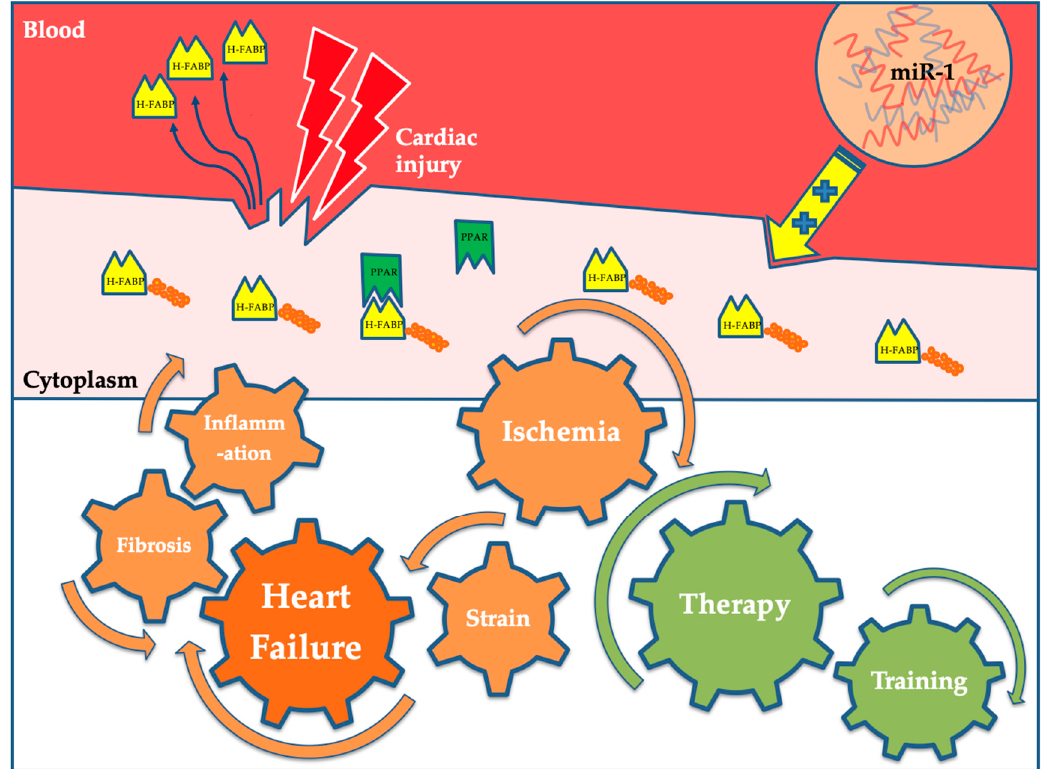
Figure 1. Under physiological conditions, H-FABP serves as a transport protein in cellular metabolism and can reversibly bind fatty acids. Furthermore, it can activate PPARs and therefore plays a role in lipid metabolism and energy homeostasis. The expression of H-FABP is regulated by the microRNA miR-1. In response to cardiac injury, H-FABP is rapidly released into the blood-stream where it can be quantified. Physical training as well as pharmacological interventions like anti-tachycardic therapy were shown to decrease plasma levels of H-FABP. Abbreviations: miR-1: microRNA 1; PPAR: peroxisome proliferator activated receptor (PPAR). H-FABP: heart-type fatty acid-binding protein.